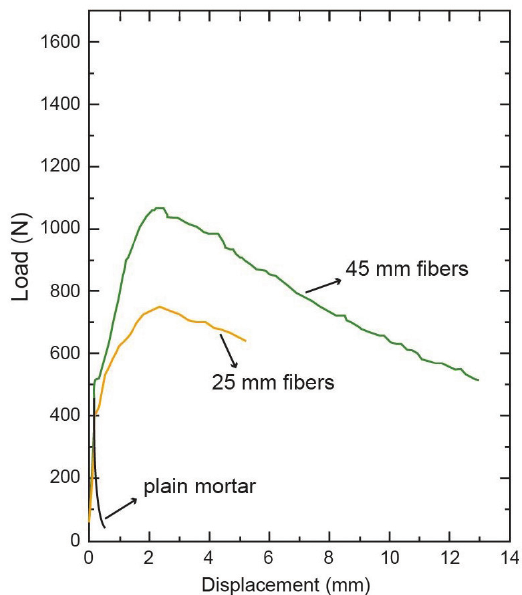
Figure 4. Mortars’ load-displacement curves in three point bending for 0.5 mm root radius.